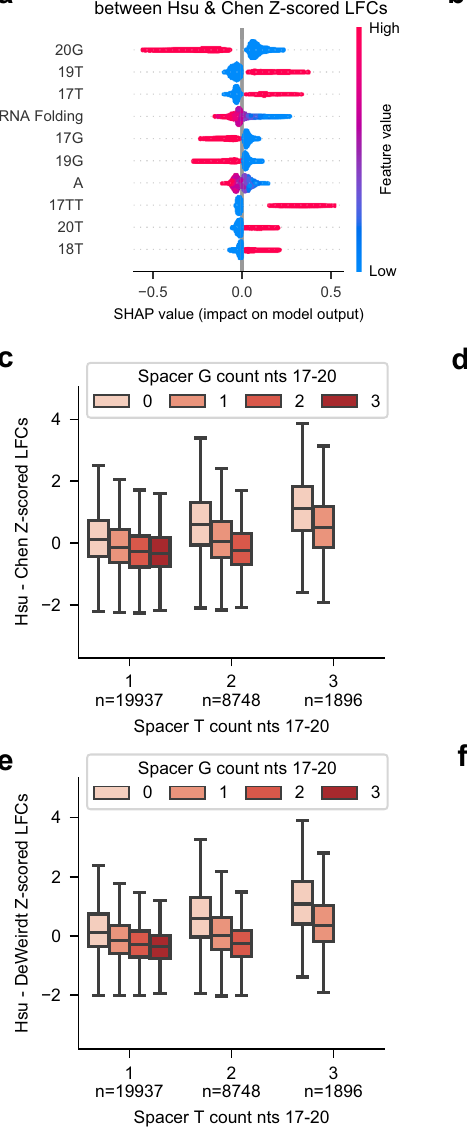
Fig. 3 | Analysis of differences in tracrRNA activity. a SHAP feature importance for the 10 most important features for predicting the difference between sgRNAs screened with the Hsu versus Chen tracrRNA. Each point represents one sgRNA from the training set. Descriptions of model features can be found in Supple- mentary Data 3. b Box plot of the difference in z-score log-fold changes between sgRNAsscreenedwiththeHsuversusChentracrRNAasafunctionof G/Tpresence inpositions17 – 20ofeachspacersequence.The ‘ ~ ’ symbolindicatesthenucleotide is not present in this range. Box minima and maxima represent the 25th and 75th percentile, whisker minima and maxima represent the 25th and 75th percentile minus and plus 1.5× the interquartile range, respectively, and the box centers